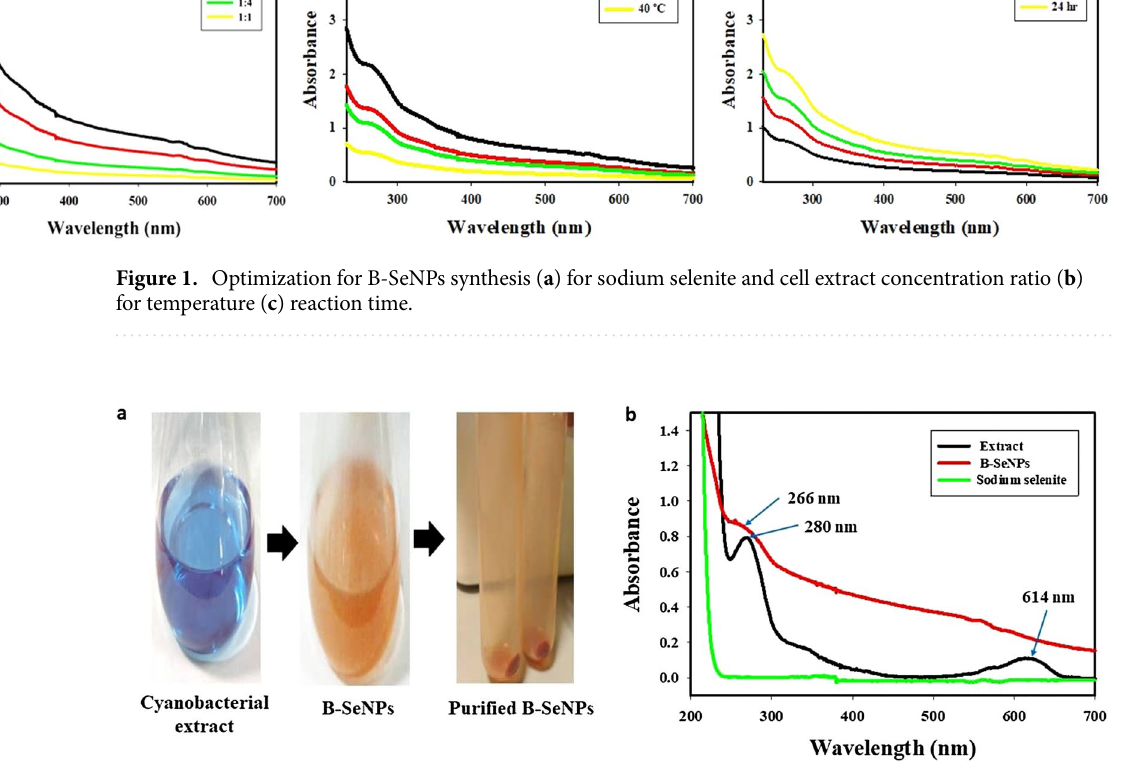
Figure 2. Synthesis of biogenic SeNPs ( a ) visual change in the reaction mixture after SeNPs synthesis, ( b ) UV– Vis spectra of B-SeNPs, sodium selenite and cyanobacterial